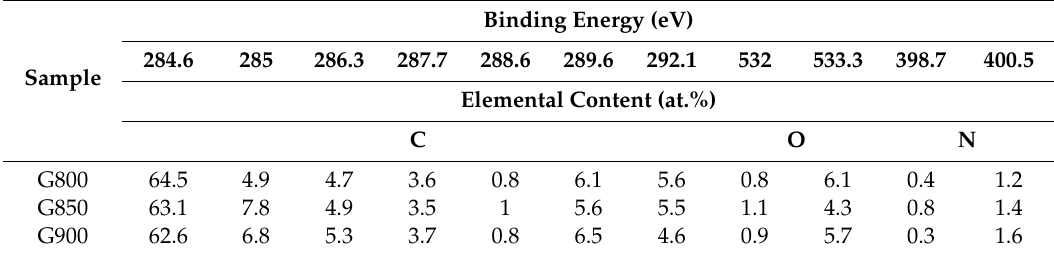
Table 1. Chemical composition analyzed by XPS for the G800, G850, and G900